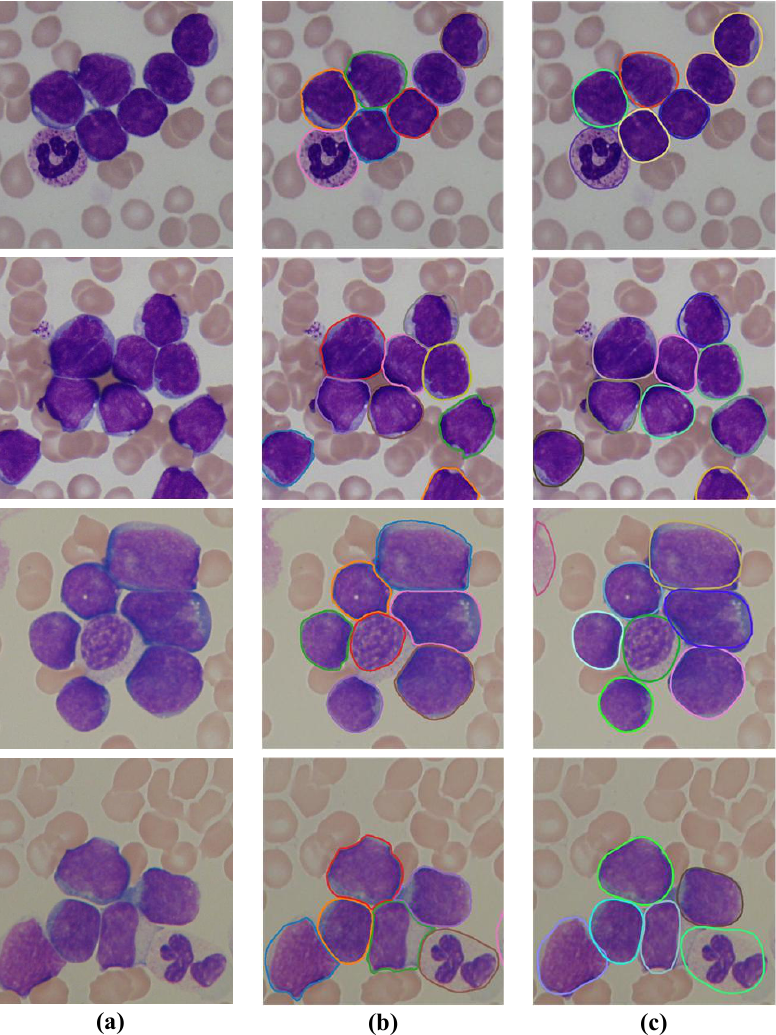
Figure 7. Segmentation results of the SPCNet model on the ALL-IDB dataset. ( a ) Input images, ( b ) the corresponding ground truths, and ( c ) the predicted